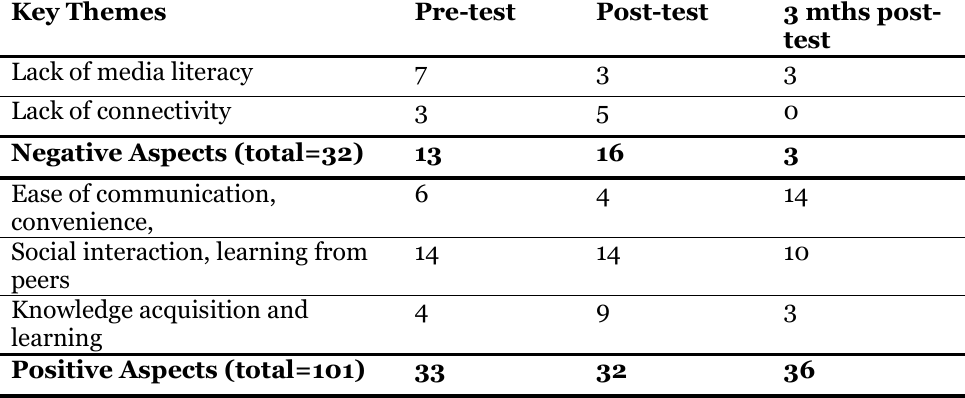
Key Themes from Comments on the Educational Use of Facebook Key